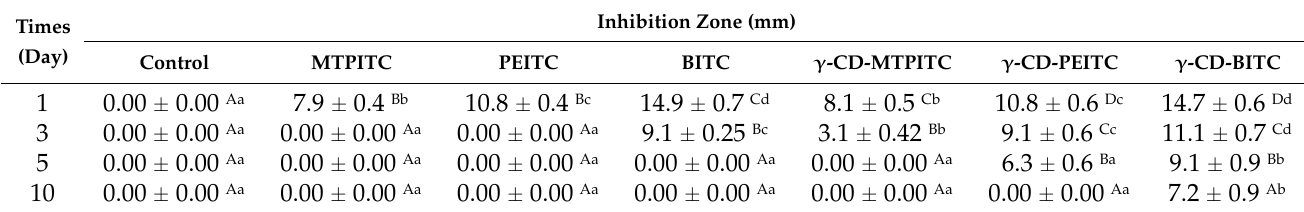
Table 1. The diameters of inhibition zone of ITCs and γ -CD-ITCs against S. aureus